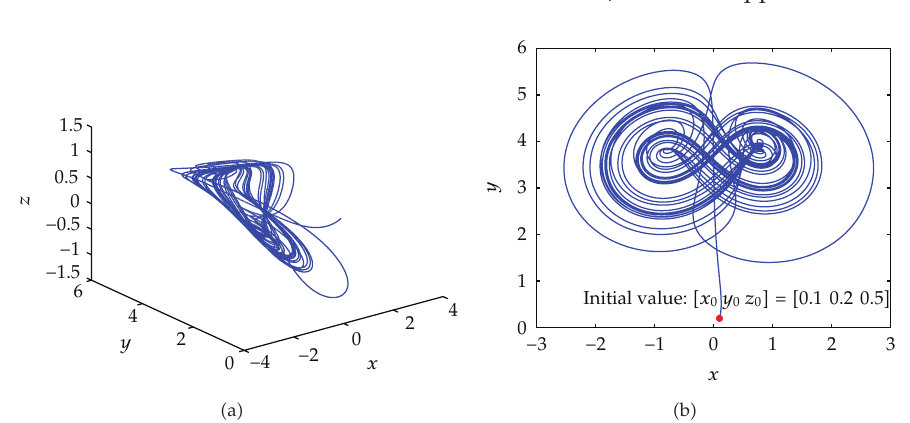
Figure 2: The numerical solutions of Example 4.2 with integer order derivatives and step size h (cid:7) 0 . 01 (cid:3)(cid:3) a (cid:4) 3D portrait; (cid:3) b (cid:4) x - y projection (cid:4) .